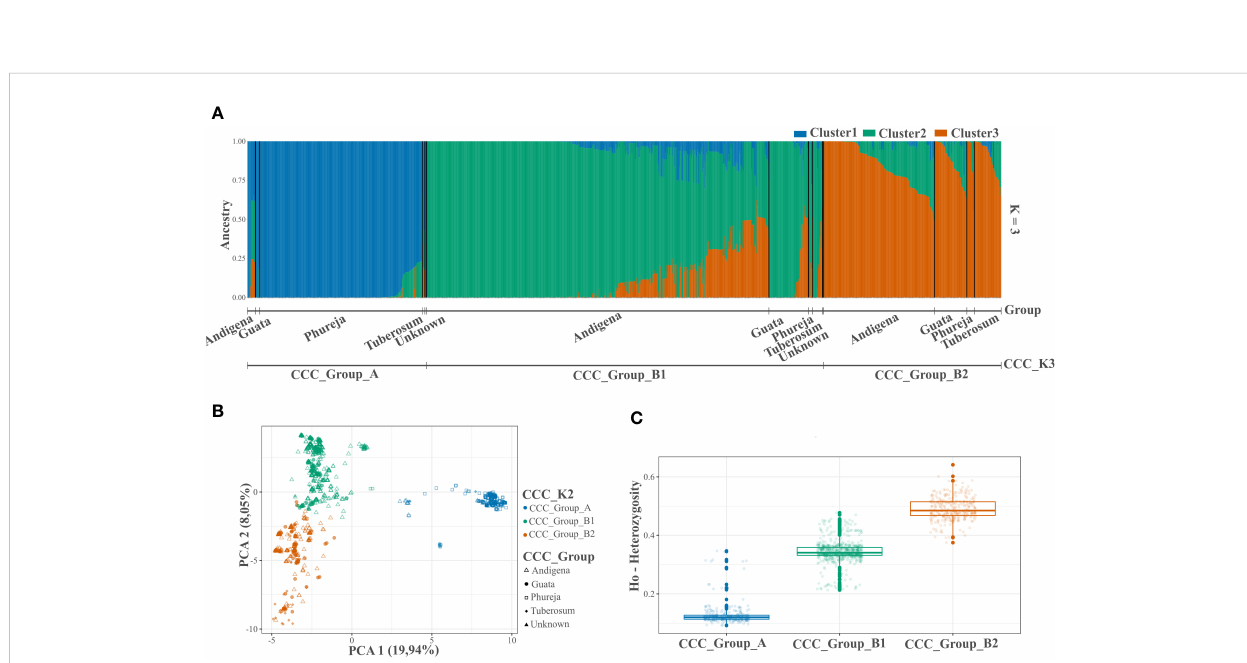
FIGURE 2 Population structure and genetic diversity analyzes of the Colombian Central Collection (CCC) of potatoes for three genetic groups (CCC_K3). (A) Bar plot of genetic structure analysis for three genetic groups (K=3) identi fi ed using the NbClust R-package and designated as CCC_Group_A, CCC_Group_B1, and CCC_Group_B2 (lower line). The AGROSAVIA in-house biological status germplasm classi fi cation (CCC_Group) is indicated in the upper line (Andigena, Phureja, Tuberosum, “ Guata ” and Unknown), (B) Scatter plot of the Principal Component Analysis (PCA) color coded by genetic group and shaped following AGROSAVIA in-house biological status classi fi cation (CCC_Group), and (C) Box plot with distribution (box representing the second and third quartiles; line across the median, and vertical line representing the range of data) with distribution of observed heterozygosity (Ho) for each genetic